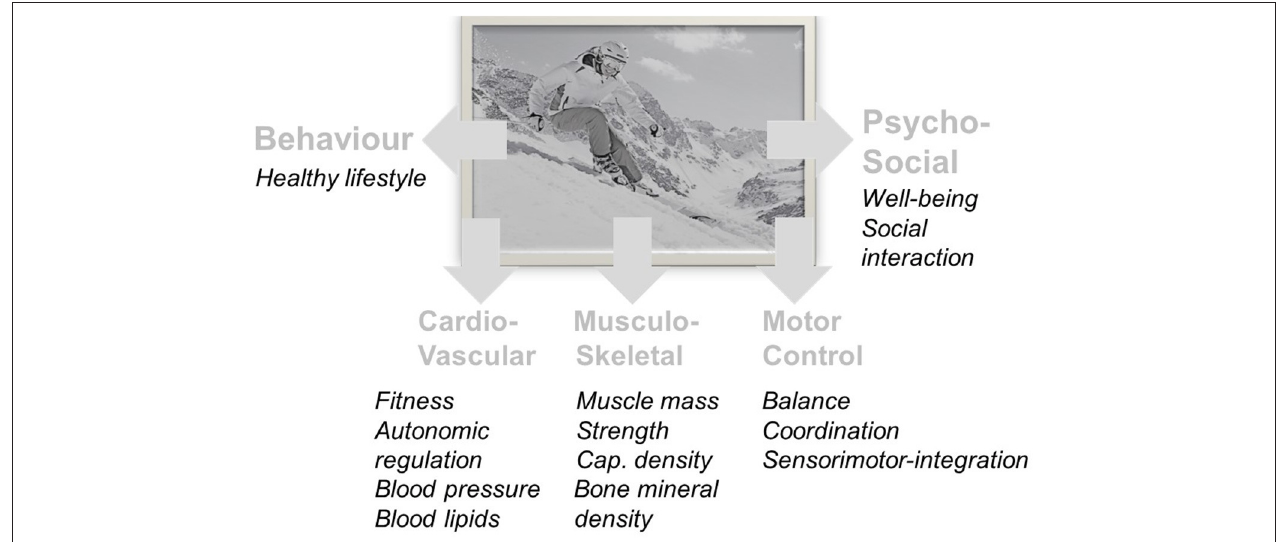
FIGURE 2 | Suggested main favorable effects of downhill skiing on